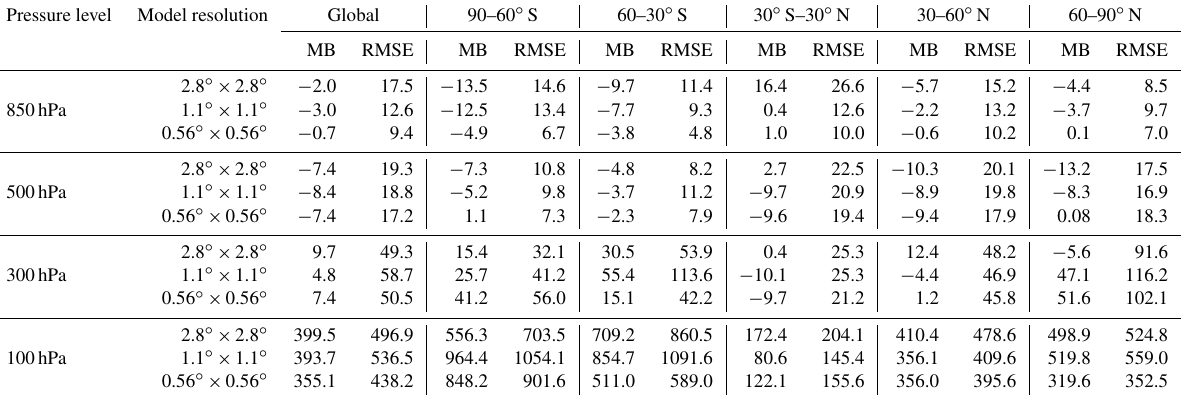
Table 2. Comparisons of seasonal mean tropospheric O 3 concentration during JJA in 2008 between ozonesonde and the model simulation at 2.8, 1.1, and 0.56 ◦ resolutions. Units are ppbv. Pressure